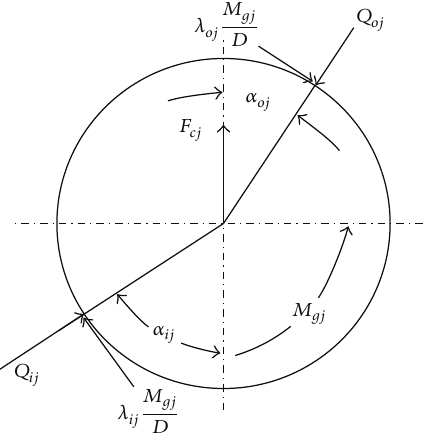
Figure 2: The forces on the